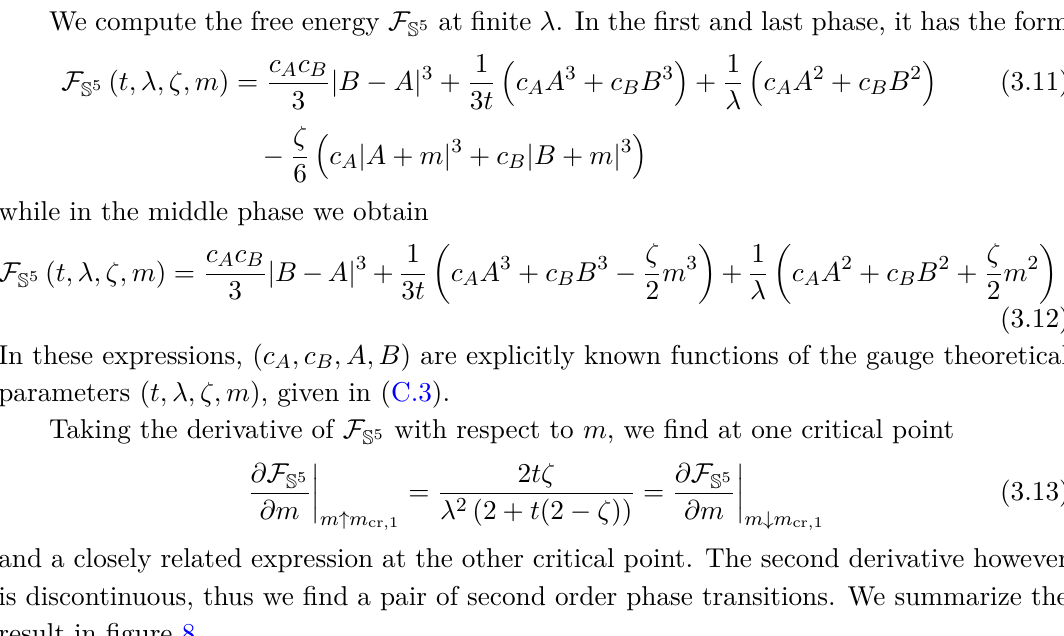
Figure 7 . Critical surfaces plotted as functions of λ . Left: m cr , 1 ( t, λ, ζ ) at ζ = 1 Right: m ( t, λ, ζ ) at ζ = 1 and t = 5 . The blue horizontal line is the asymptote m = 0 cr , 2 2